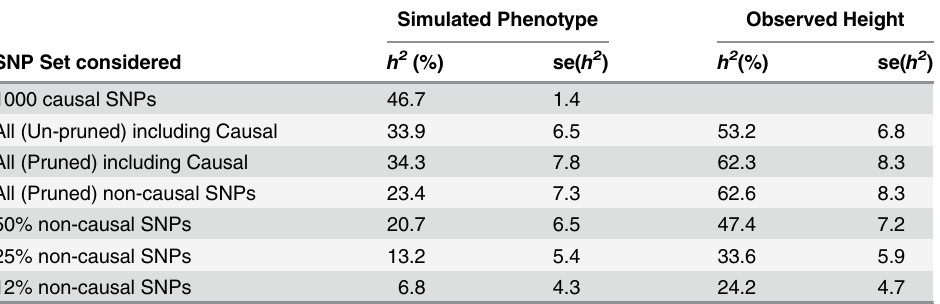
All analyses corrected for age, sex, study site, and 10 principal components. The un-pruned SNPs were those 966,578 passing quality control measures and the 452,696 pruned SNPs were selected by PLINK